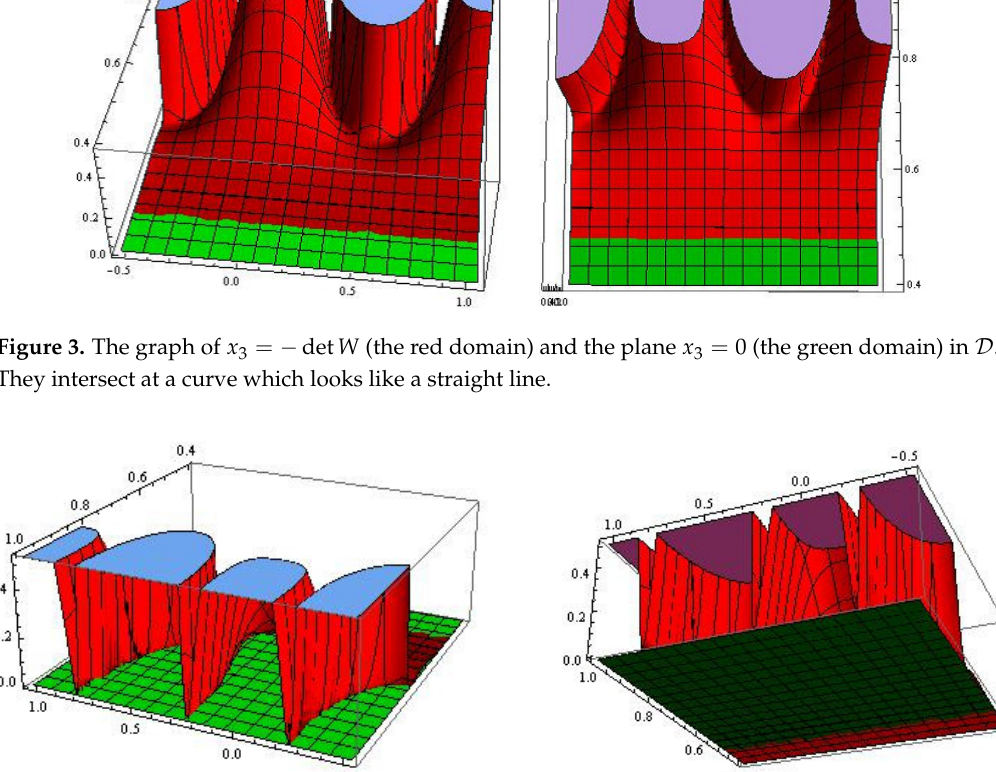
det W (the red domain) and the plane x 3 = 0 (the green domain) in Figure 4. The graph of x 3 = − The former seems to be tangent to the latter at some curves which look like parabolic